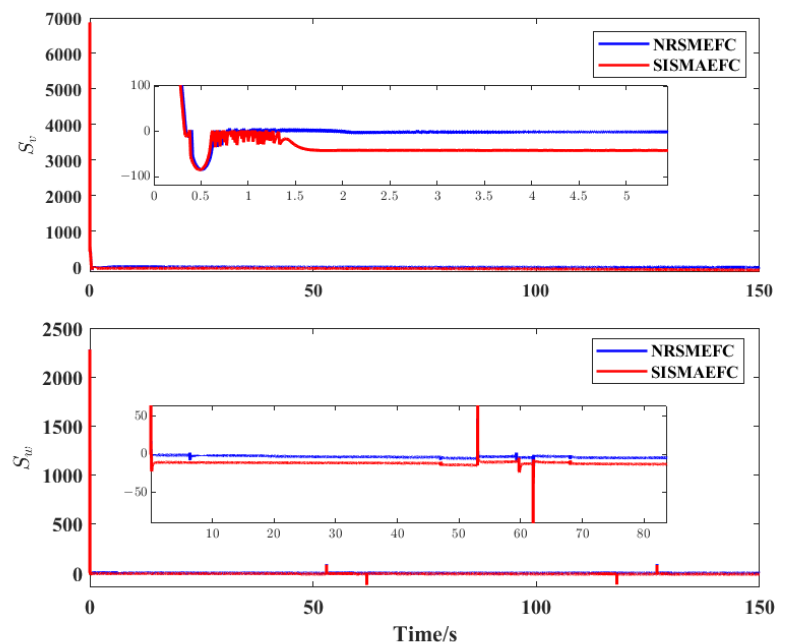
Figure 8. Sliding surface S R